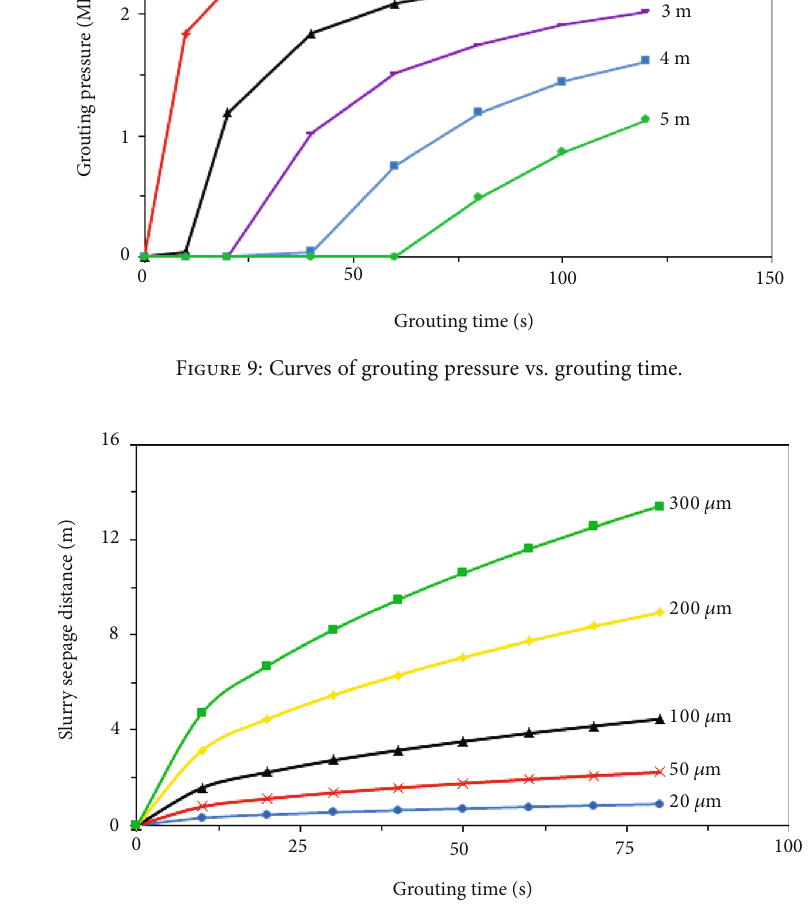
Figure 10: Slurry seepage distance for di ff erent fracture openings with no fl uid-solid coupling.